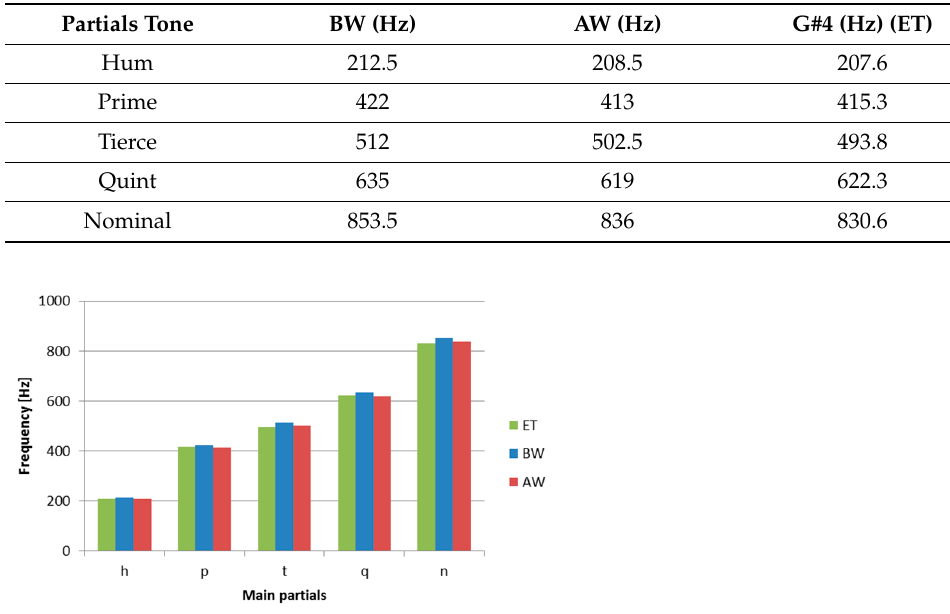
Figure 11. The main partials of the St. Maryan bell’s sound frequencies, before (BW), after (AW) welding and for musical note G#4 according to the equal temperament scale (ET).